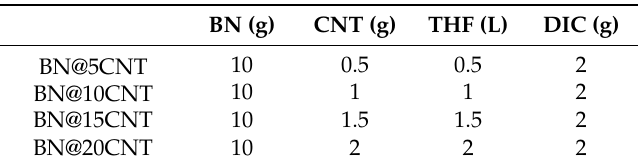
Table 1. Formula of